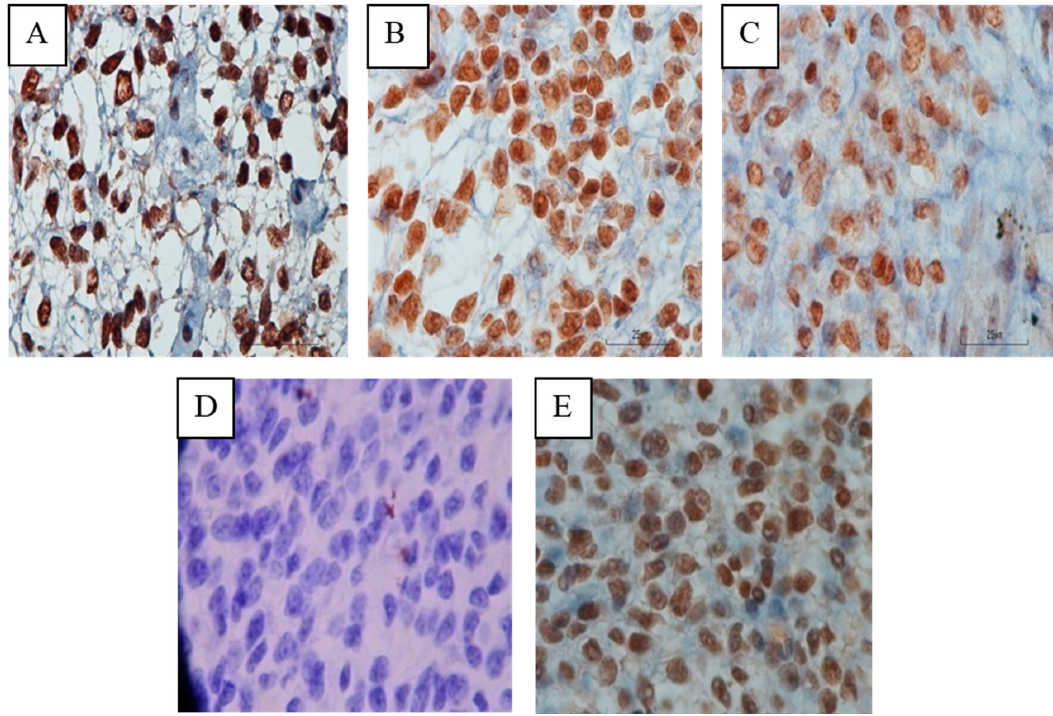
Figure 4. Immunohistochemistry HOXA10 in Macaca nemestrina endometrial tissue. The natural cycle ( A ); the stimulated cycle with P4< 1 ng/mL ( B ); the stimulated cycle with P4> 1 ng/mL ( C ); negative control ( D ) and positive control ( E ). Magnification 1000×.